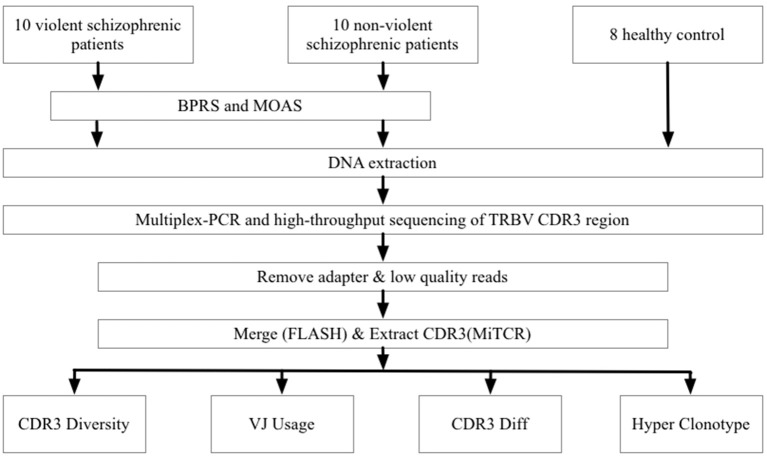
Study flowchart of experiment and data processing.